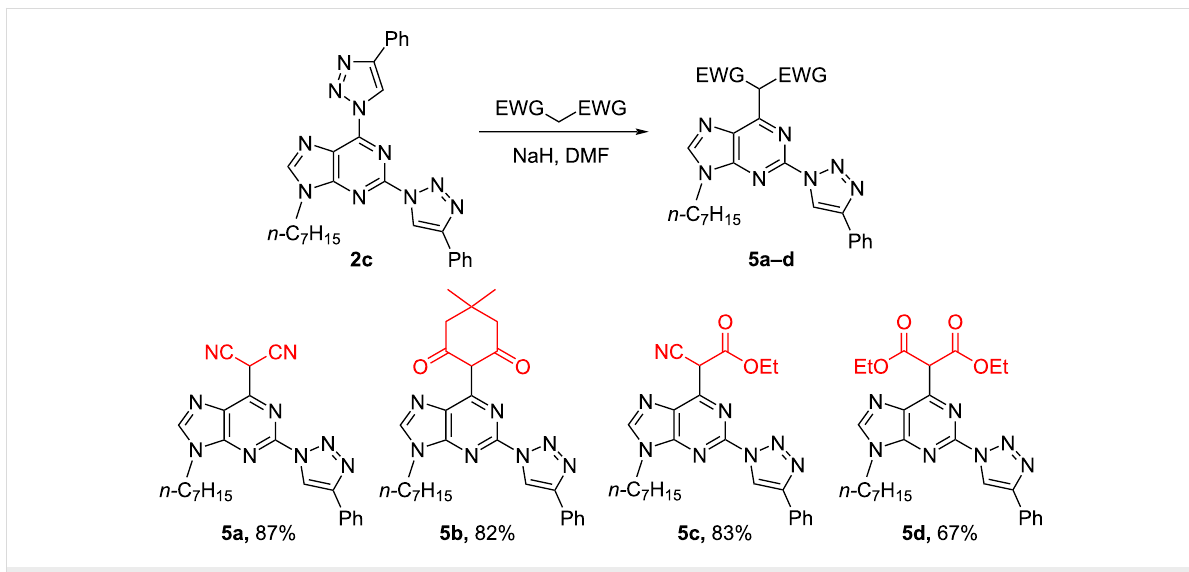
Scheme 6: Synthesis of C6-substituted 2-triazolylpurine derivatives 5